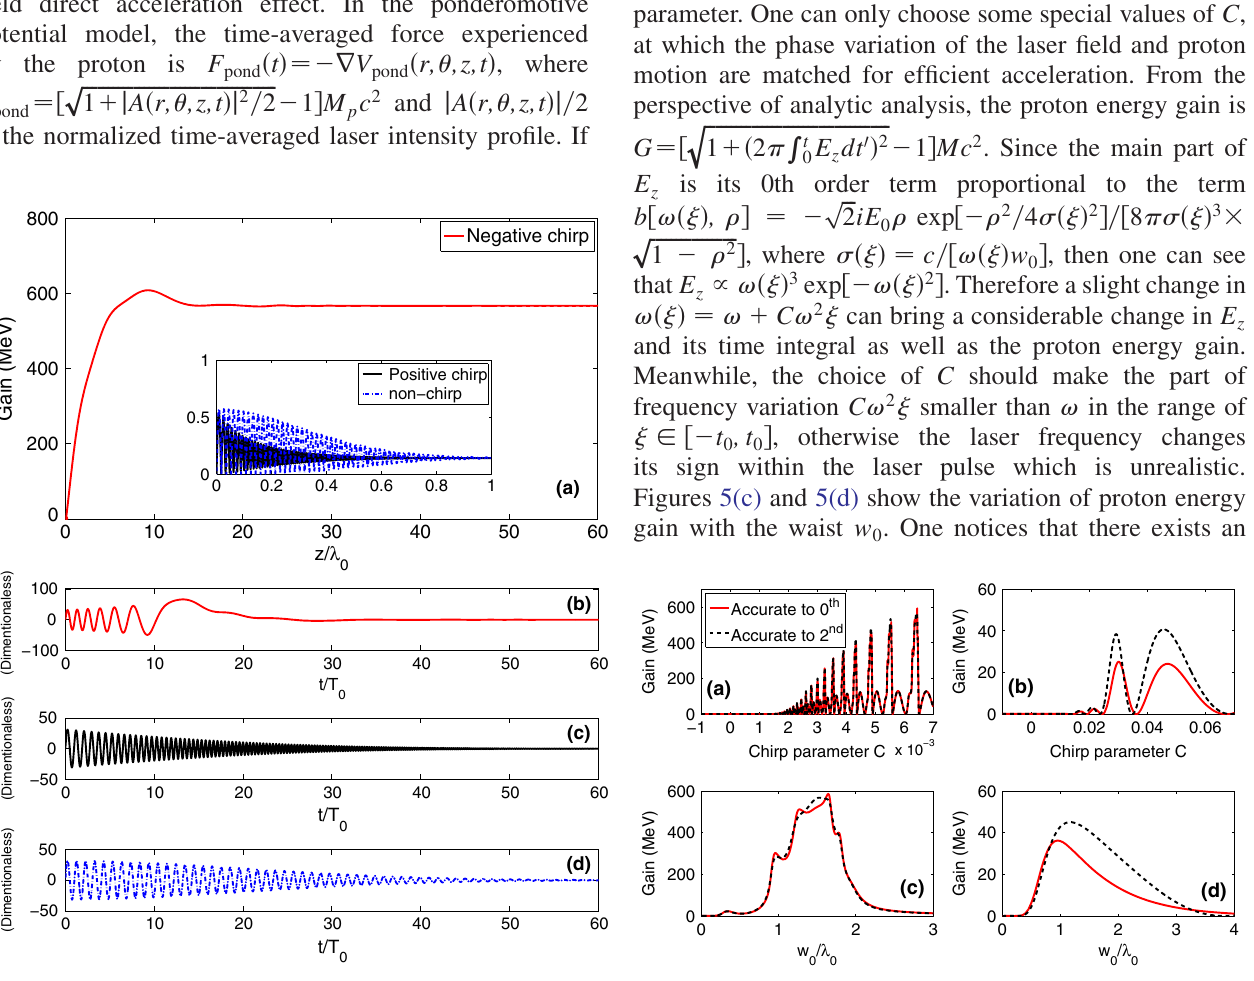
FIG. 4. (a) Energy gain of a test single proton as a function of acceleration distance for the laser pulse with different frequency chirp parameters. The initial coordinates of the test proton is ð r; (cid:1); z Þ ¼ ð 0 ; 0 ; 0 Þ and it starts from rest. The laser parameters are the same as in Fig. 3. Plots (b), (c), and (d) show the ! c=e ) by the test proton when the laser pulse is either m e 0 negatively, positively chirped, or not chirped, respectively.